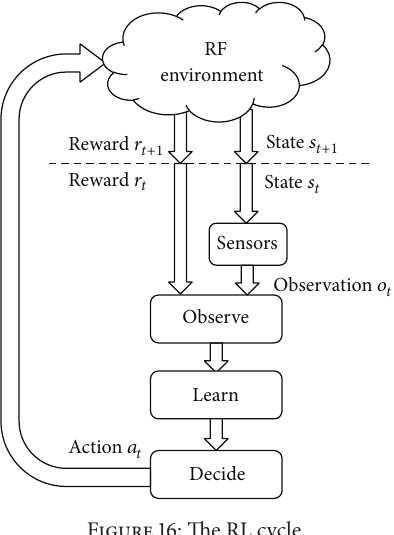
Figure 16: The RL